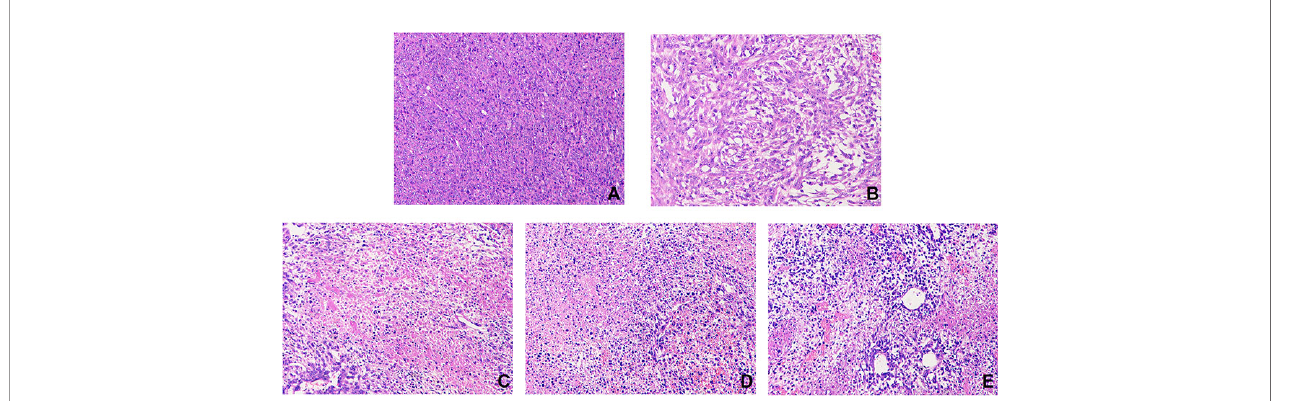
FIGURE 7 | Effect of THSWD on tumor cells in mice. Sections were stained with H&E. Magni fi cation, ×200; scale bars, 50 m m. Model group (A) , cisplatin group (B) , THSWD H group (C) , THSWD M group (D) , THSWD L group (E) .